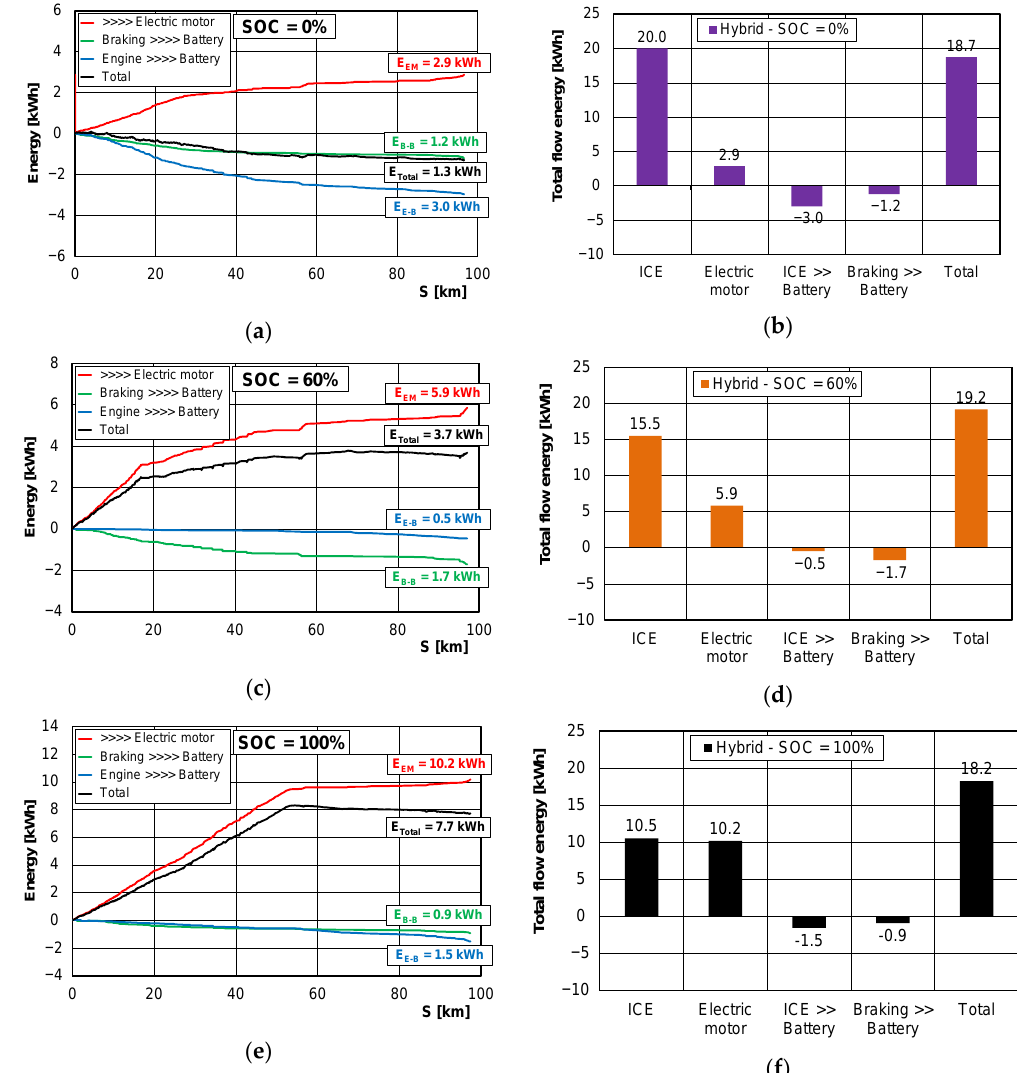
Figure 13. The energy flow for the hybrid vehicle for different states of charge ( a , c , e ) and the Figure13. Theenergyflowforthehybridvehiclefordi ff erentstatesofcharge( a , c , e )andtheaccumulated accumulated energy demand of the vehicles ( b , d , f ). energy demand of the vehicles ( b , d , f